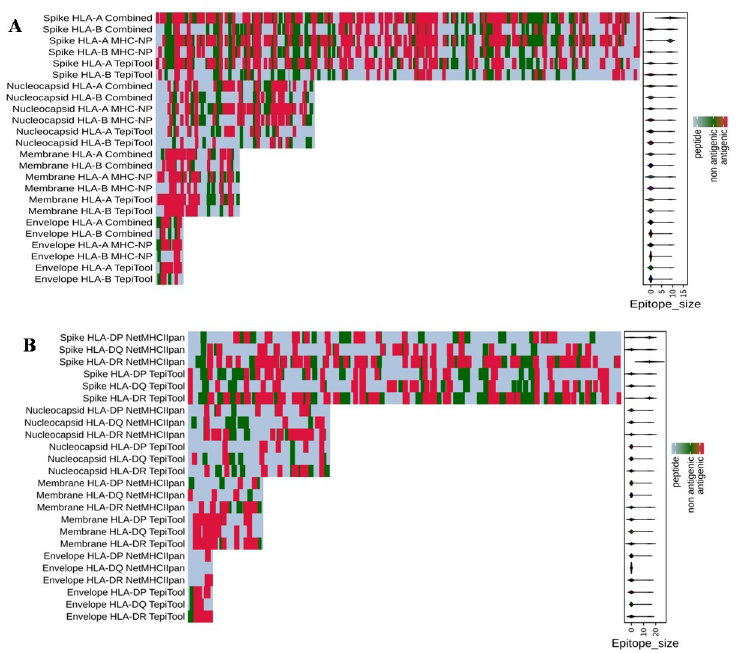
Fig 5. Summary of SARS-CoV-2-derived T-cell epitopes. Heat map showing the distribution of (a) HLA class I and (b) HLA class II epitopes across the protein sequences of spike (1273 aa), nucleocapsid (419 aa), membrane (222 aa), and envelope (75 aa) proteins of SARS-CoV-2. Red color represents antigenic epitopes predicted using the methods described in Fig 1.